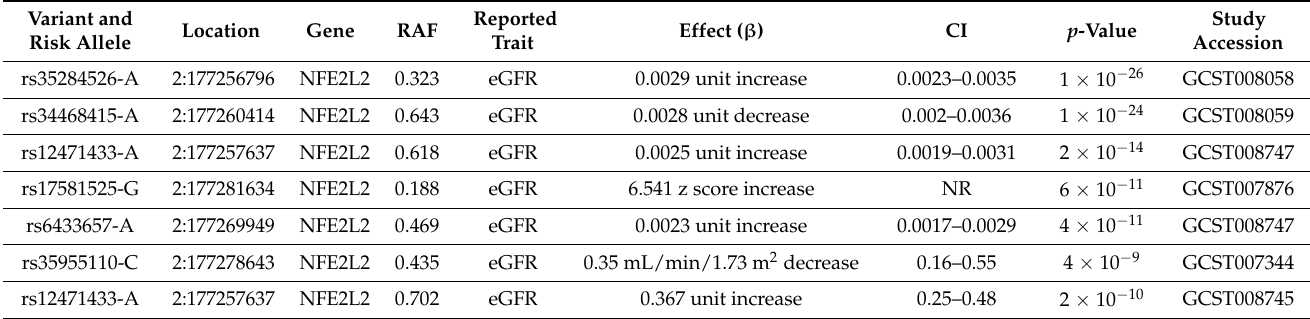
Table 1. Genome-wide significant evidence of the Nrf2-eGFR